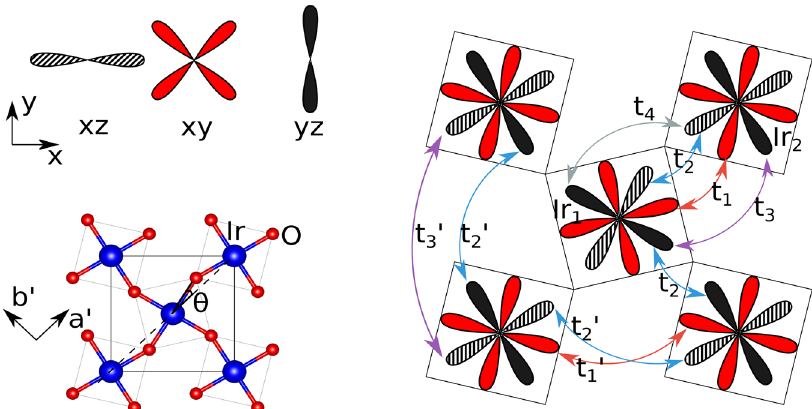
Fig. 1 In-plane structure of Sr 2 IrO 4 and the notation for orbital overlap parameters. For nearest neighbors (NN), interorbital overlap parameters are denoted t 1 , t 2 , t 3 , and intraorbital t 4 , and for second nearest neighbors (2NN) we consider interorbital overlap only: t 0 , t 0 , t 0 . Orbital overlap between third neighbors is de fi ned in the same way, not shown. Due to the symmetry considerations, the overlap of out-of- plane t 2g orbitals is anisotropic: t 2 describes hopping between xz ( yz ) along a 0 ( b 0 ) axis. The O-Ir-Ir angle θ characterizes the in-plane octahedra rotation as